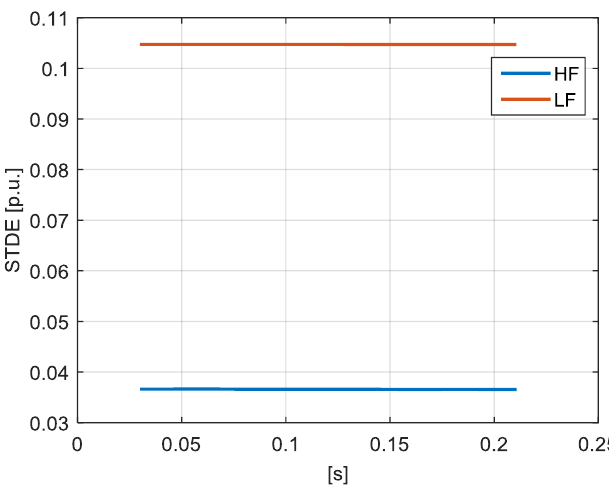
Figure 7. Case study 1: STDE at low-frequency (0 ÷ 2 kHz, red line) and at high-frequency (2 ÷ 150